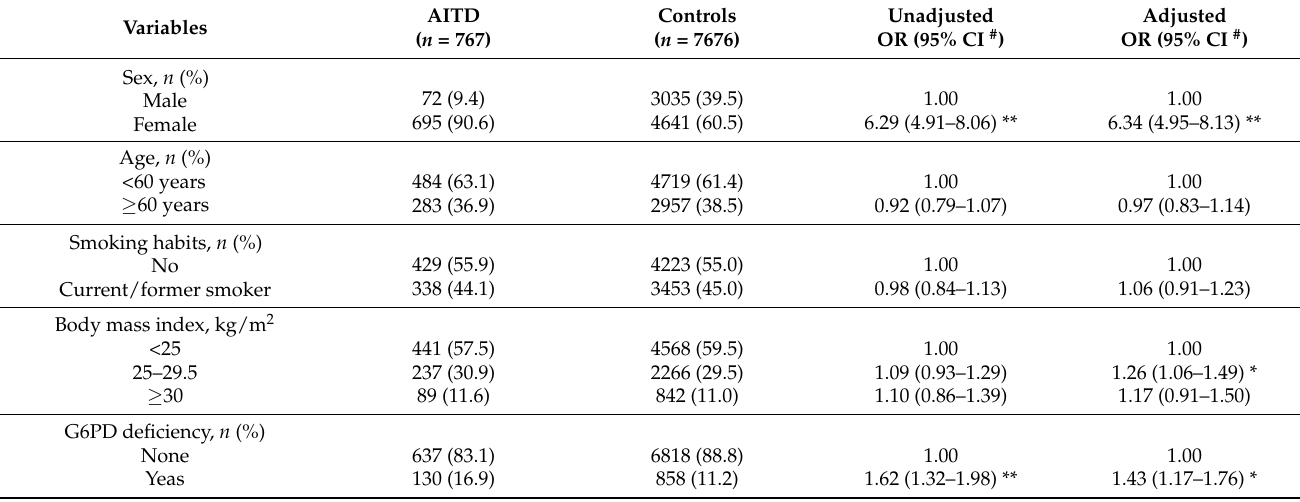
Table 3. Unadjusted and adjusted Odds Ratios for autoimmune thyroid disease (AITD) among patients included in the